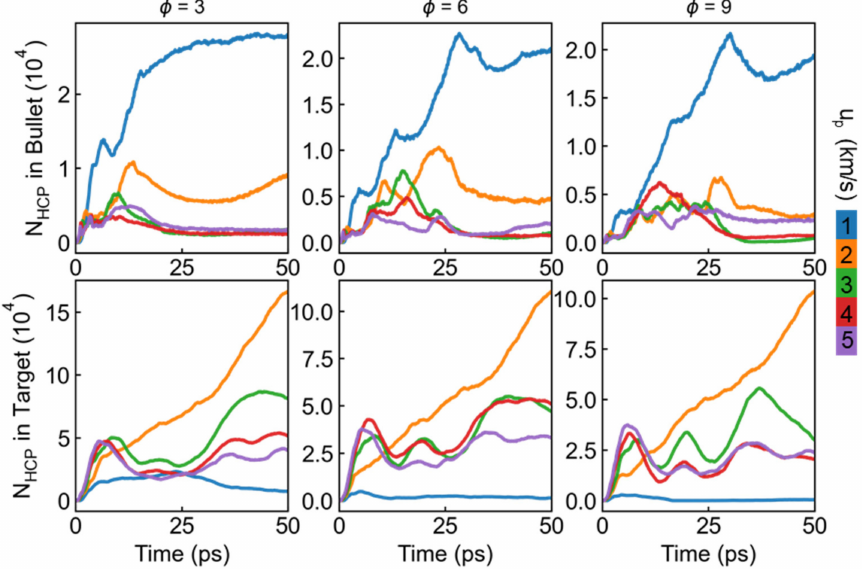
Figure 8. History of the number of HCP atoms N hcp in bullet and target for different draw ratio and incident